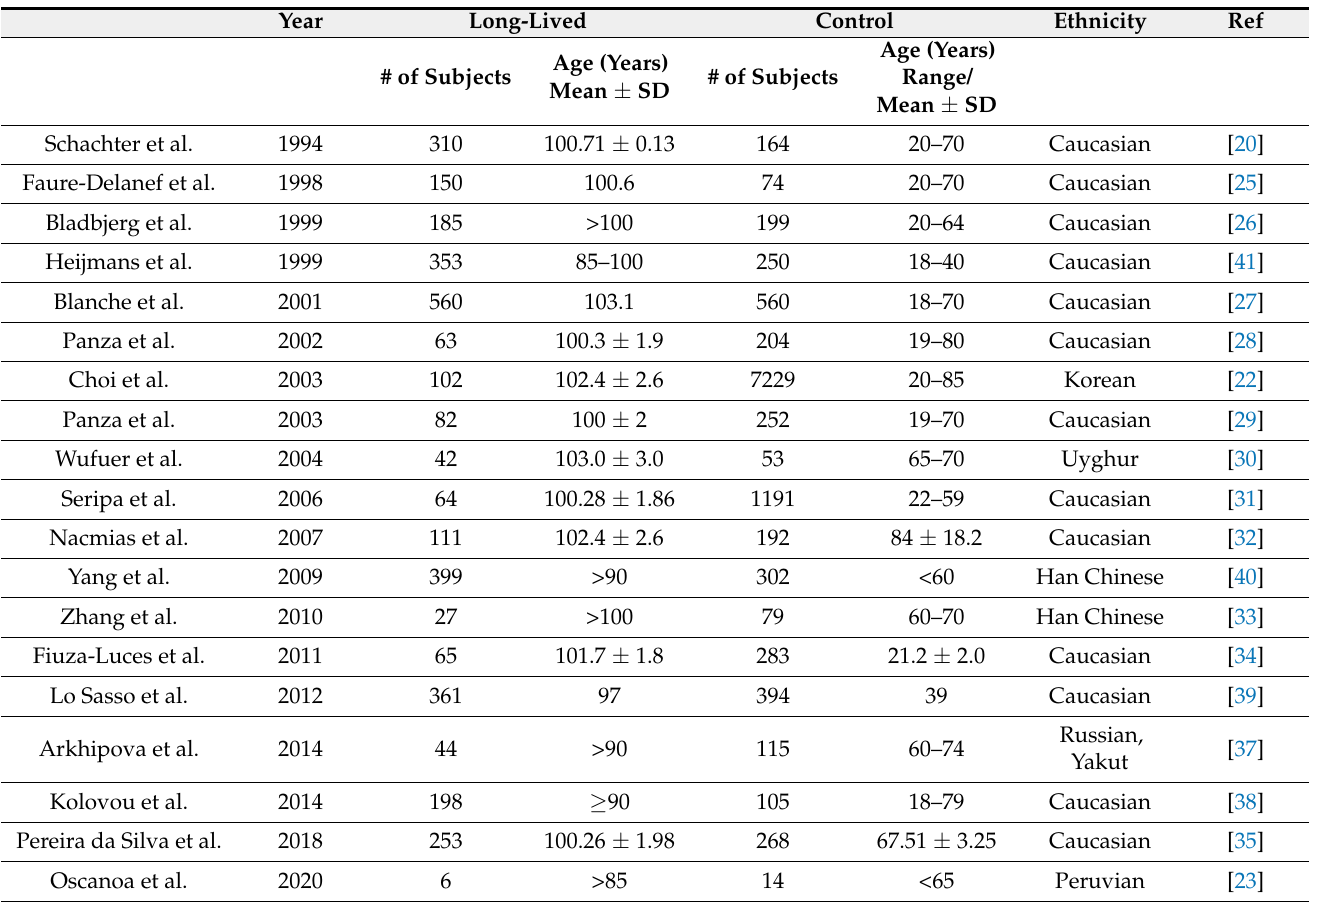
Table 2. Characteristics of studies on ACE I/D polymorphisms in long-lived individuals (85+ years old).